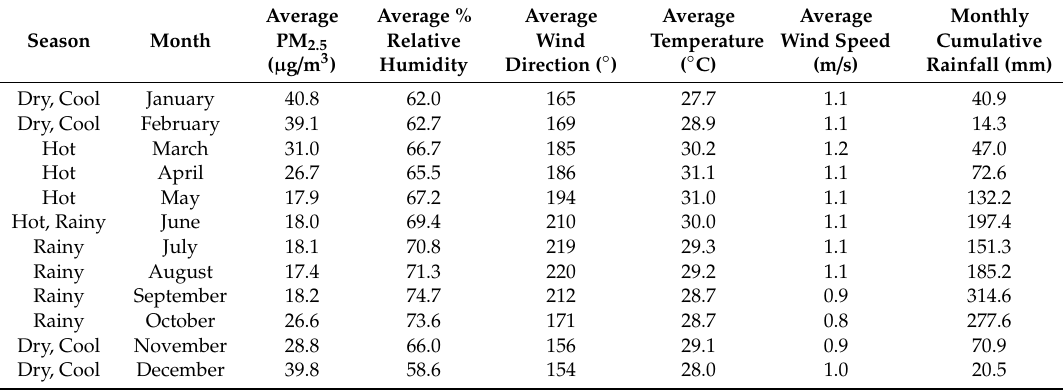
Table 2. Seasonal variance in meteorological indicators and PM 2.5 concentrations in